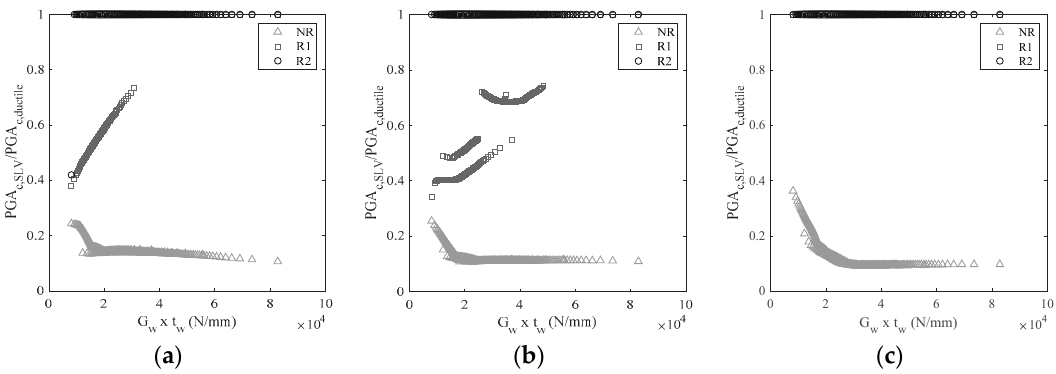
Figure 13. Variation of PGA c,SLV / PGA c,ductile with G w t w for ( a ) three-storey, ( b ) five-storey, and ( c ) seven-storey building. The effect of retrofit solution FRP + SRP is also represented.